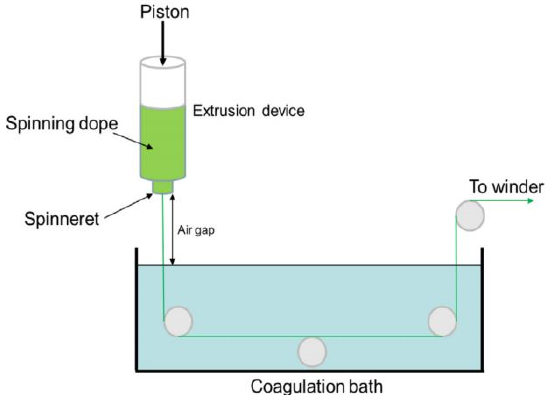
Figure 10. General scheme of dry-jet wet spinning using air gap between spinneret and coagulation bath (reprinted from International Journal of Biological Micromolecules , 2016 , 92 , 1197–1204, Boy, R.; Narayanan, G.; Chung, C.C.; Kotek, R. Novel cellulose-collagen blend biofibers prepared from an amine/salt solvent system, with permission from Elsevier).